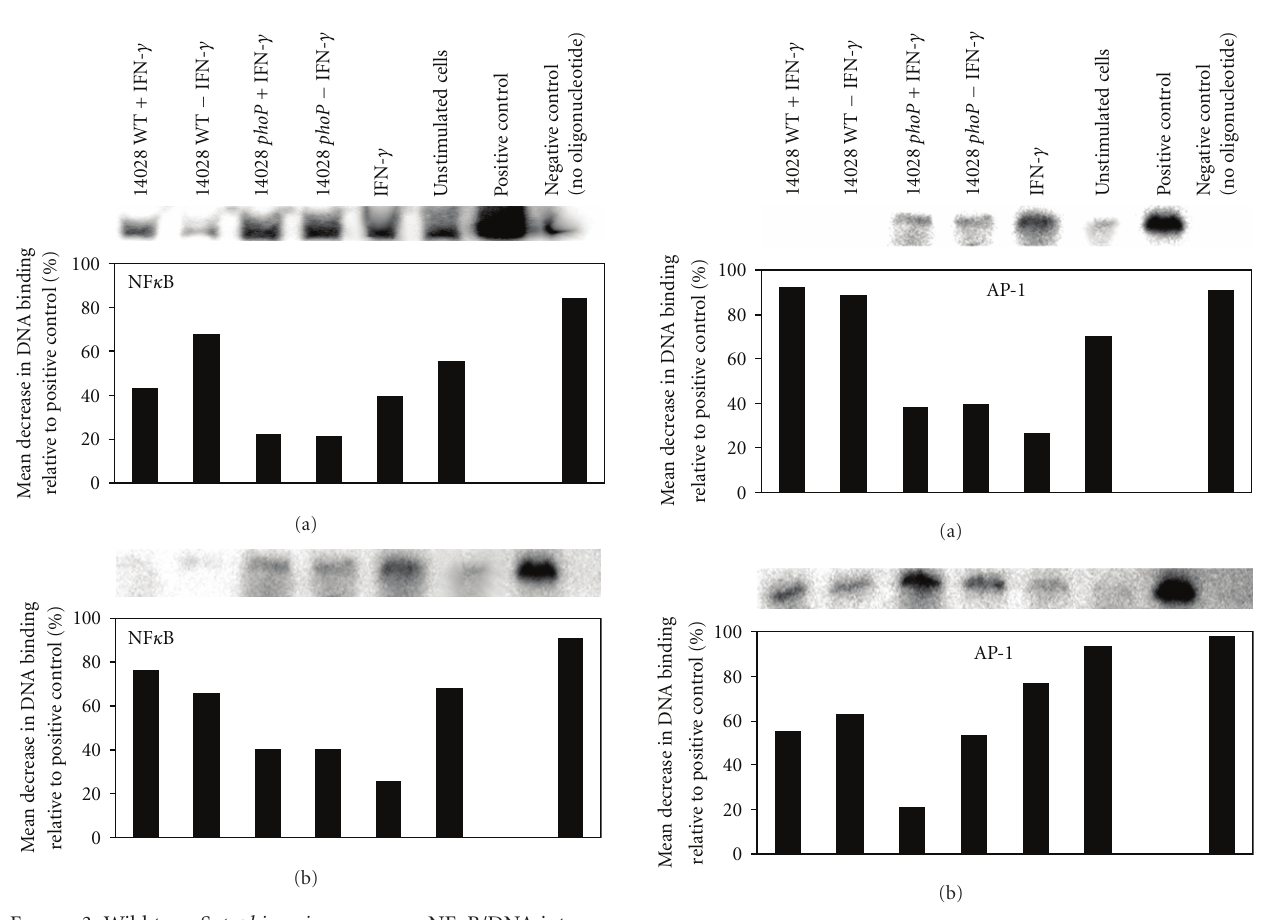
Figure 4: Wild type S. typhimurium suppresses AP-1/DNA interac- tion in J774.2 cells 2 and 12h afterculture via phoP . (a) 2h postcul- ture. (b) 12h postculture. Controls include, uninfected J774.2 cells, manufacturers kit positive control (HeLa cell nuclear lysate with oligonucleotide), and manufacturers kit negative control (HeLa cell nuclear lysate without oligonucleotide). Data is representative of EMSAa performed on 3 separate